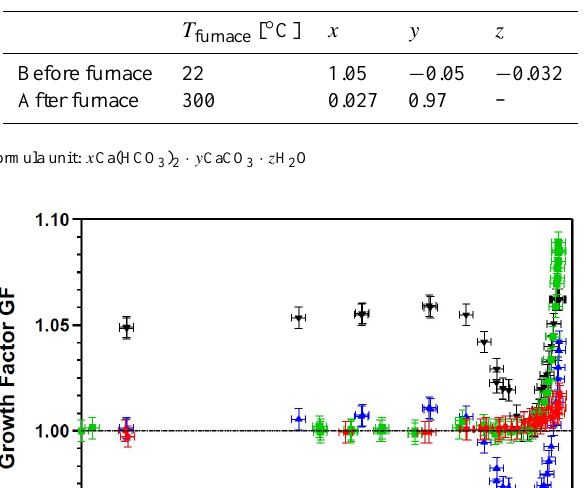
Table 2. Composition of aerosol before and after the furnace.